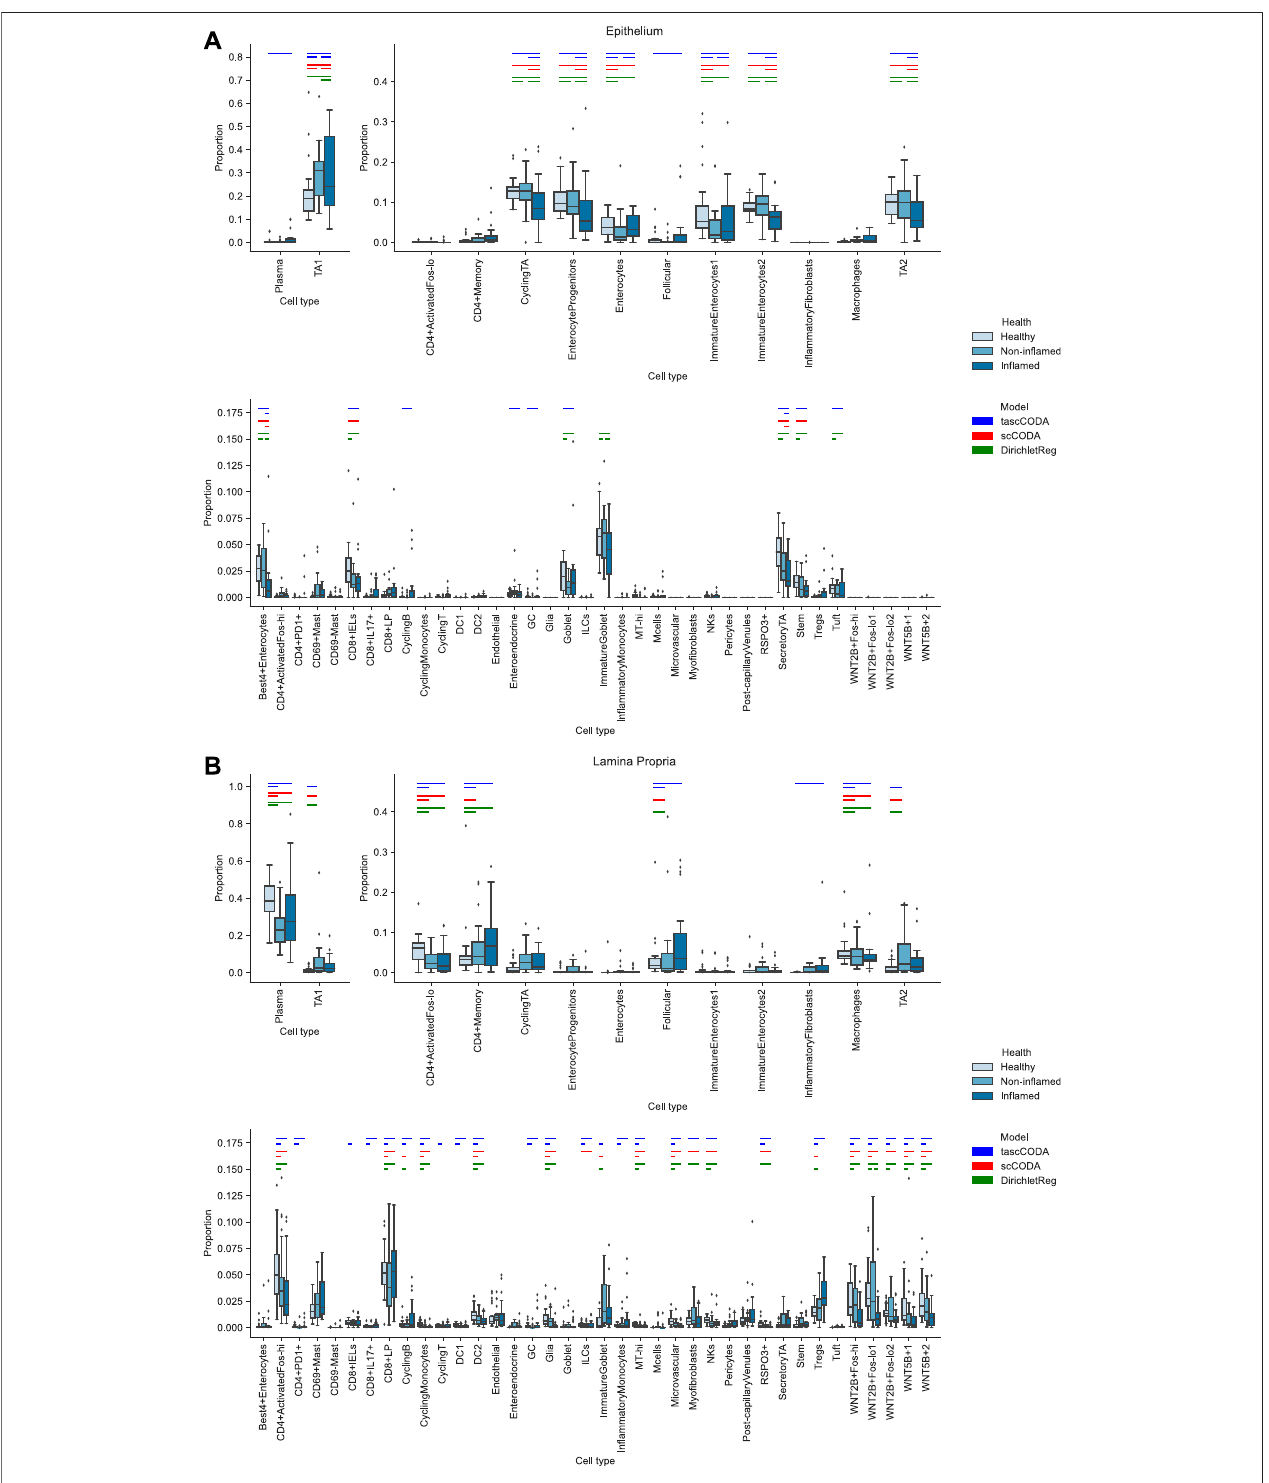
FIGURE6| Comparison ofdifferentially abundant celltypesfound bytascCODA(blue, ϕ (cid:2) 5), scCODA (red, FDR (cid:2) 0.05),and Dirichletregression(green,adjusted p adj < 0.05)betweenbiopsiesofhealthy,non-in fl amedandin fl amedtissue.Coloredbarsforeachmethodindicatethatacrediblechangewasfound. (A) Amongsamples from the intestinal epithelium, tascCODA and Dirichlet regression detect effects on lowly abundant epithelial cell types (Tuft, Goblet, Enteroendocrine) that were not detected by scCODA. (B) In the Lamina Propria, only tascCODA detects a number of effects on some of the T and B cell types.